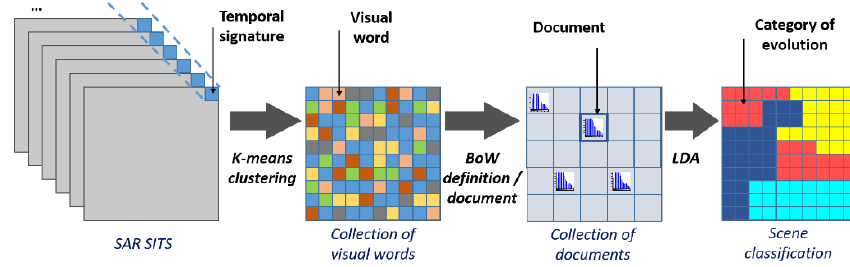
Figure 1. Proposed approach to extract categories of evolution from SAR SITS.